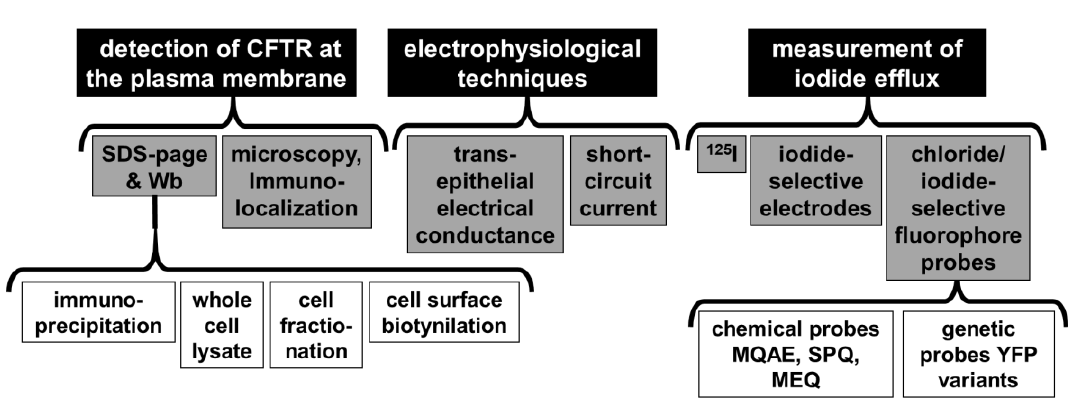
12 of 21 Figure 6. Thermostability assay. CPM labeling experiments: CPM is added to the cuvette (1) at low temperature (e.g., 10 °C) and then the protein is added (2). After a period of labeling of surface exposed Cys residues, the cuvette is heated (starting at 3). Initially the CPM fluorescence decreases due to thermal quenching, but then as the protein unfolds, the CPM fluorescence rises, reaching a maximum after the protein is completely unfolded. After this, thermal quenching of the CPM fluorescence is again observed. Left panel shows typical CPM unfolding profiles for different membrane proteins. Trace a (the solid line) is for a membrane protein such as CFTR with about 40% of its 18 Cys residues exposed to the aqueous medium. It shows a single cooperative unfolding